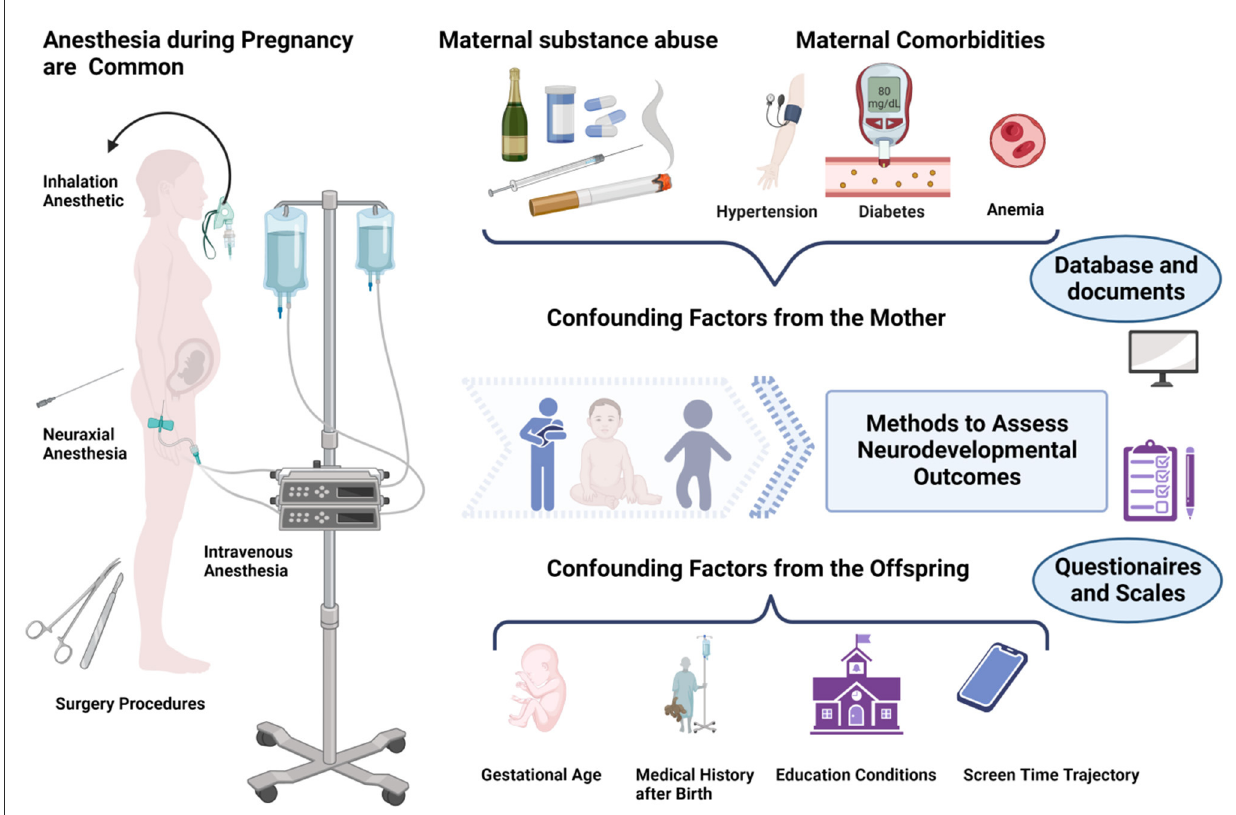
FIGURE1 Maternal exposure to anesthesia and surgery during pregnancy may affect the neurodevelopment of the offspring. However, there are many influencing factors to consider ranging from intrauterine exposure to the offspring tests. Figure created with BioRender.com.